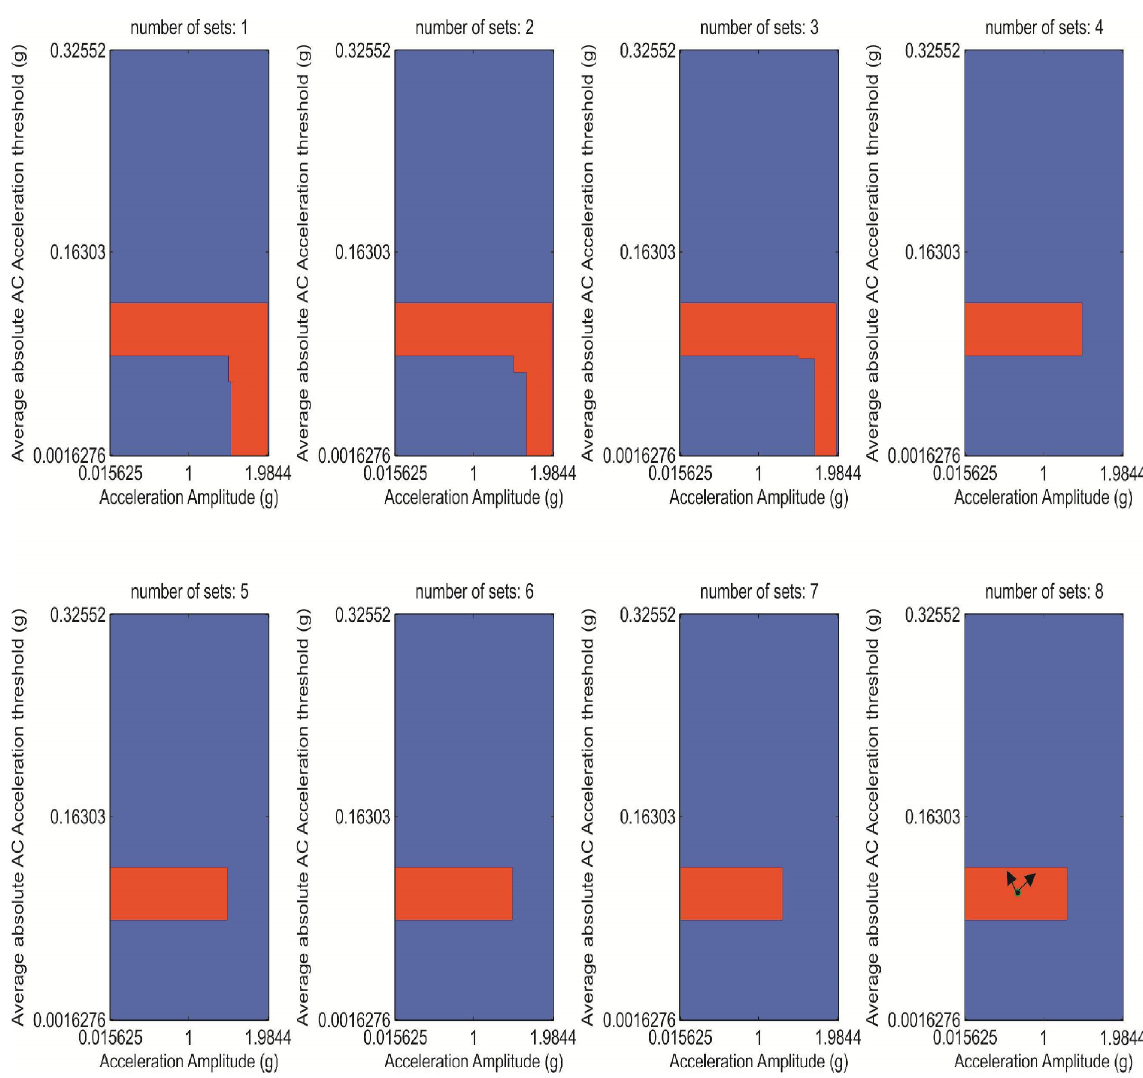
Figure 3. Optimum space region of the personalized isotropic algorithm for α = 0.4, for a growing number of activity sets, from 1 to 8. Threshold values, E (vertical) and A (horizontal), are written in terms of g units (see